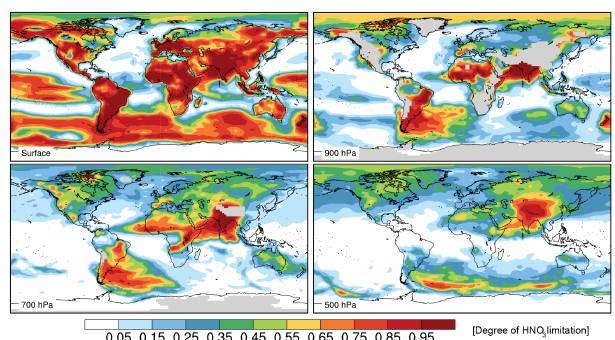
Figure 7. Simulated degree of limitation of NH 4 NO 3 formation by HNO 3 (GR > 1) weighted by NH 4 NO 3 concentration at different pressure levels in AM3N for